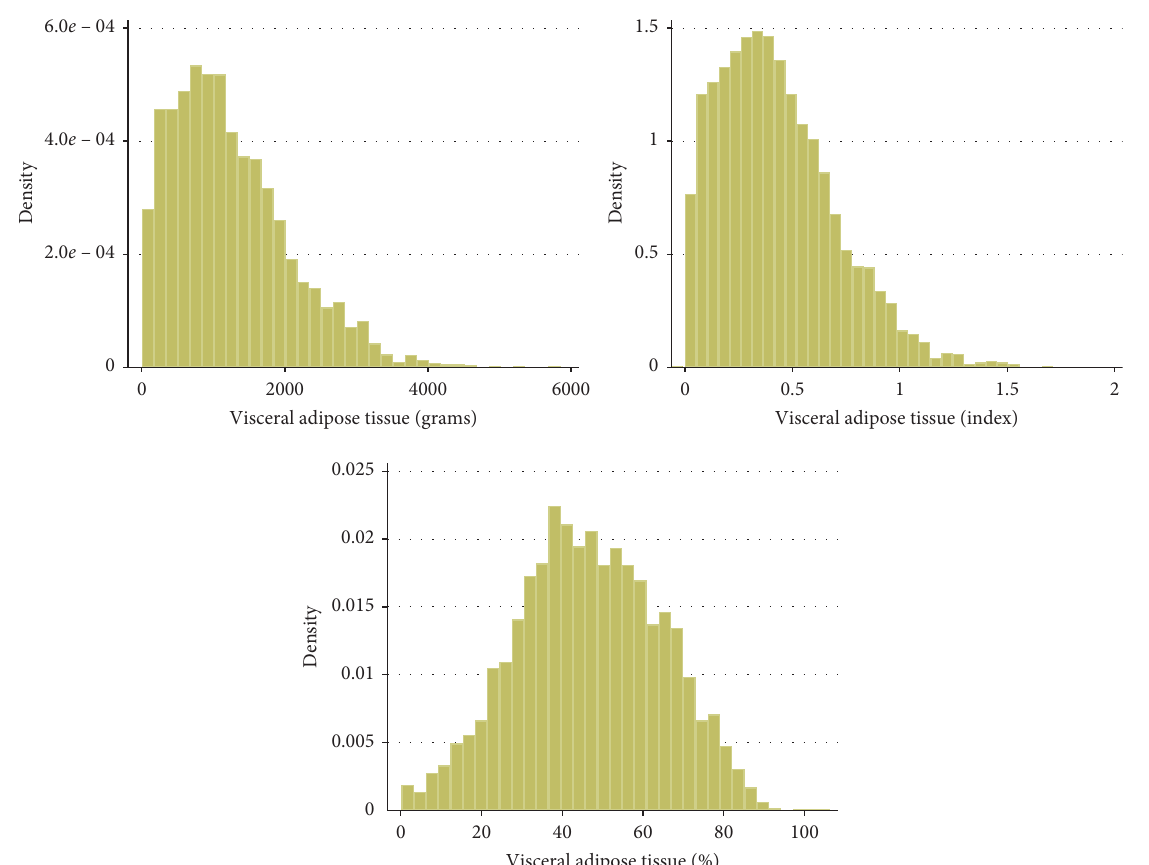
Figure 2: Normality curves of VAT (g), VAT (index), and VAT